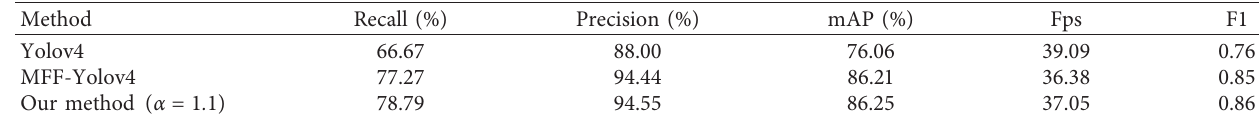
Table 3: Results of ablation